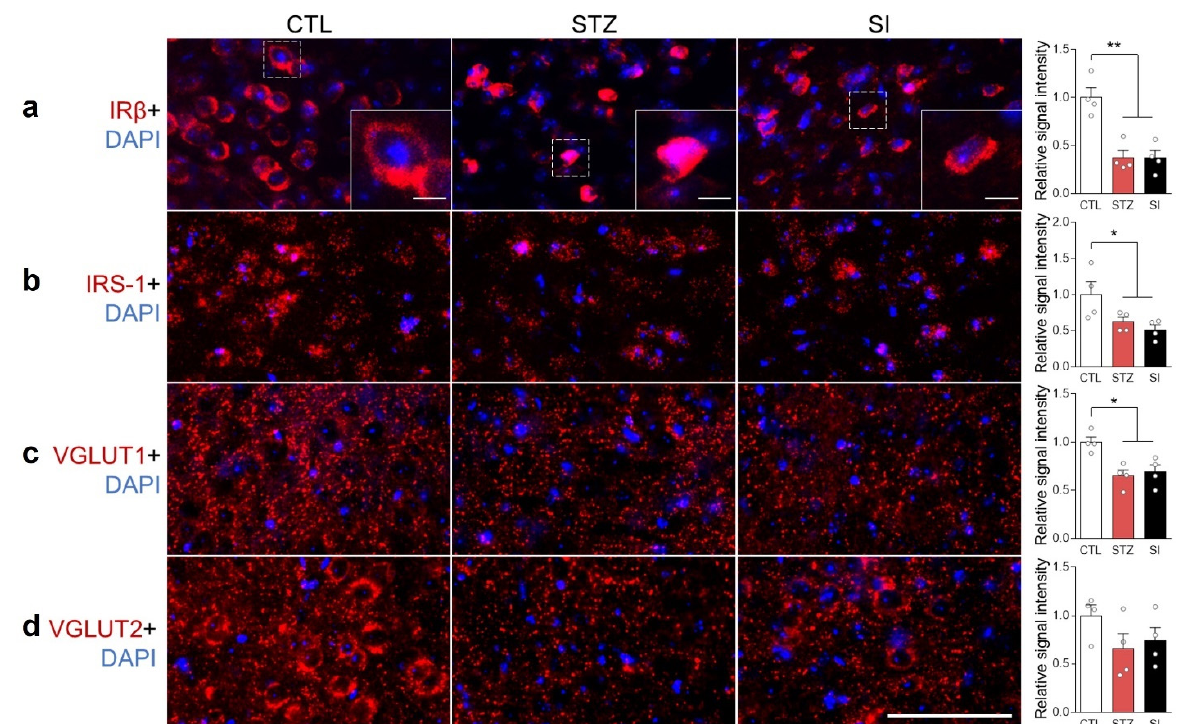
Figure 9. Hyperglycemia reduced insulin receptor β (IR β ) expression and altered its cellular locali- zation in the mPFC. Immunohistochemistry images of ( a ) IR β , ( b ) insulin receptor substrate-1 (IRS- 1), ( c ) vesicular glutamate transporter 1 (VGLUT1), and ( d ) VGLUT2 with the nuclear marker DAPI in the mPFC. Scale bar = 50 μ m. ( a ) Inset scale bar = 5 μ m. The right panel shows each signal quan- tification result. n = 4/group. Data are presented as mean ± SEM. * p < 0.05, ** p < 0.01 between indicated groups according to one-way ANOVA with Newman–Keuls post-hoc tests.